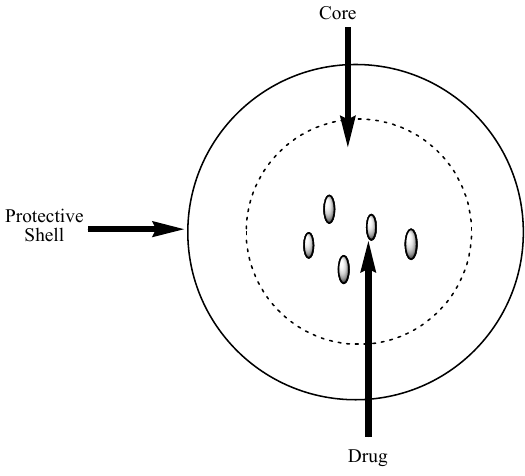
Figure 8. Schematic diagram of nanocapsules.